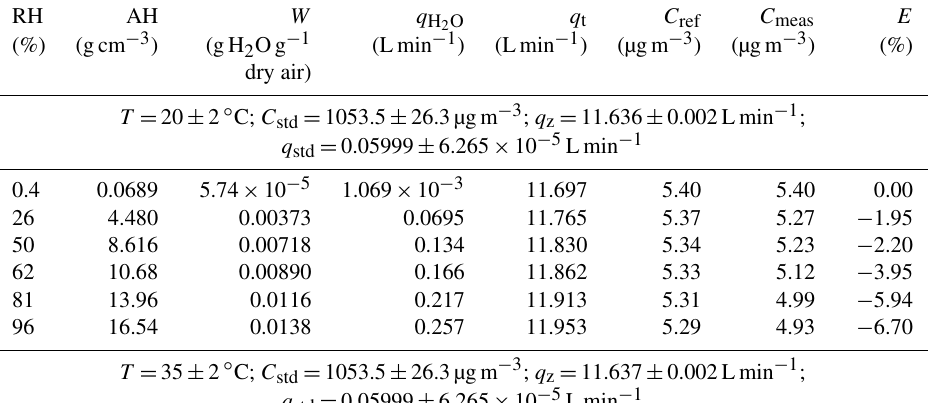
Table 3. Relative (RH) and absolute (AH) humidity, mass fraction of water vapour in the dry air ( W ), reference concentration of ben- zene ( C ref ), average reading of analyser I ( C meas ) and relative difference between measurements and reference values ( E ). q t is the total flow rate, calculated as the sum of the flow rate of zero air ( q z ), water vapour ( q H mixture ( q std ). C std is the amount fraction of benzene in the gas